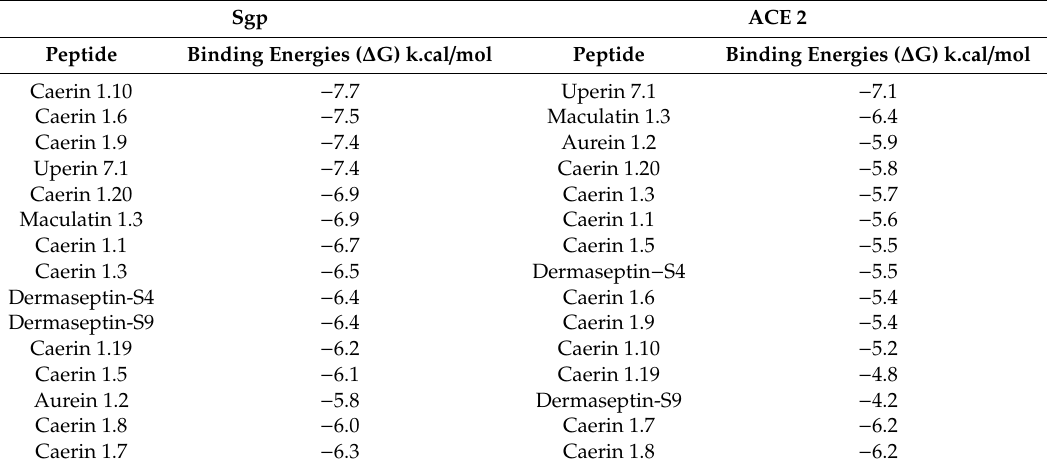
Table 4. Interactions between AMPs and SARS-CoV-2 S Sgp. In green highest results. NA: Not applicable.